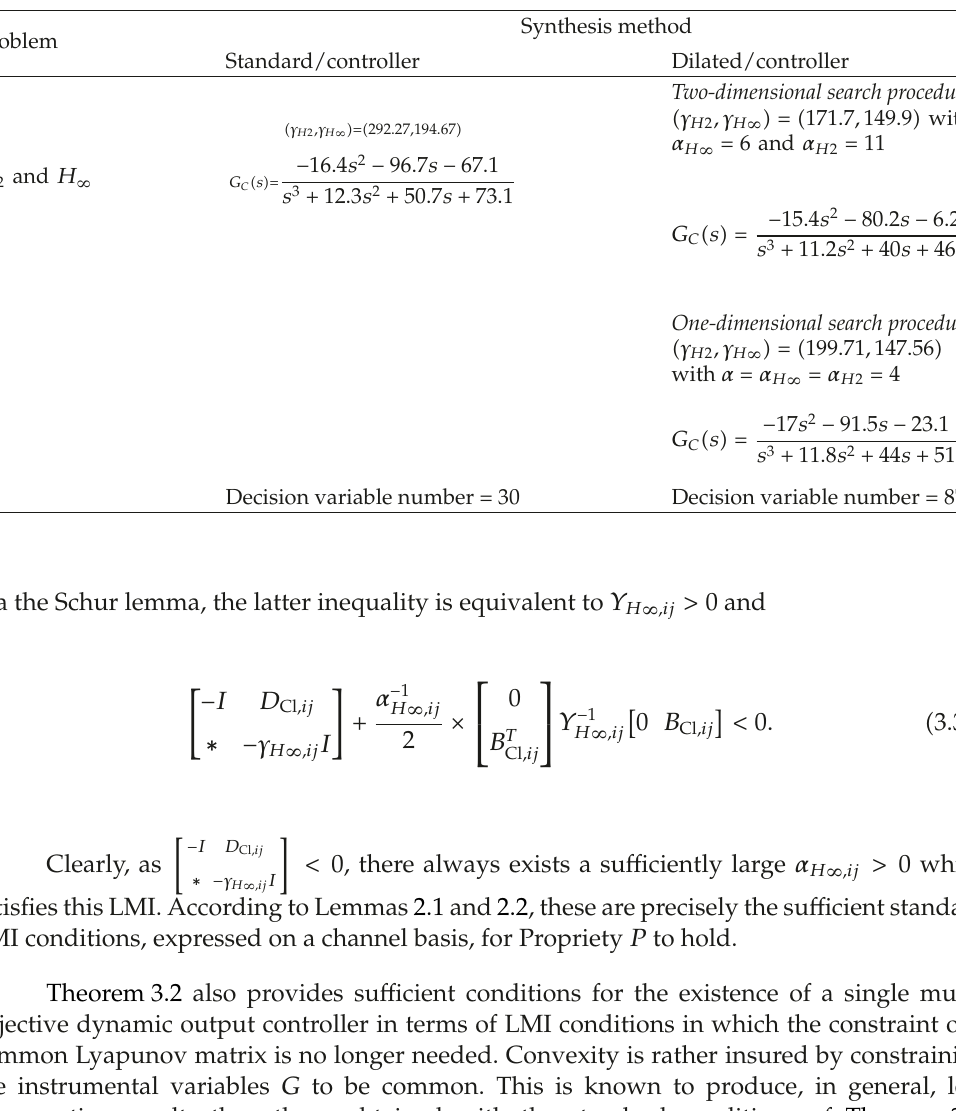
Table 1: Simulation results, with G C (cid:6) s (cid:7) representing the LMI produced full-order dynamic output feedback